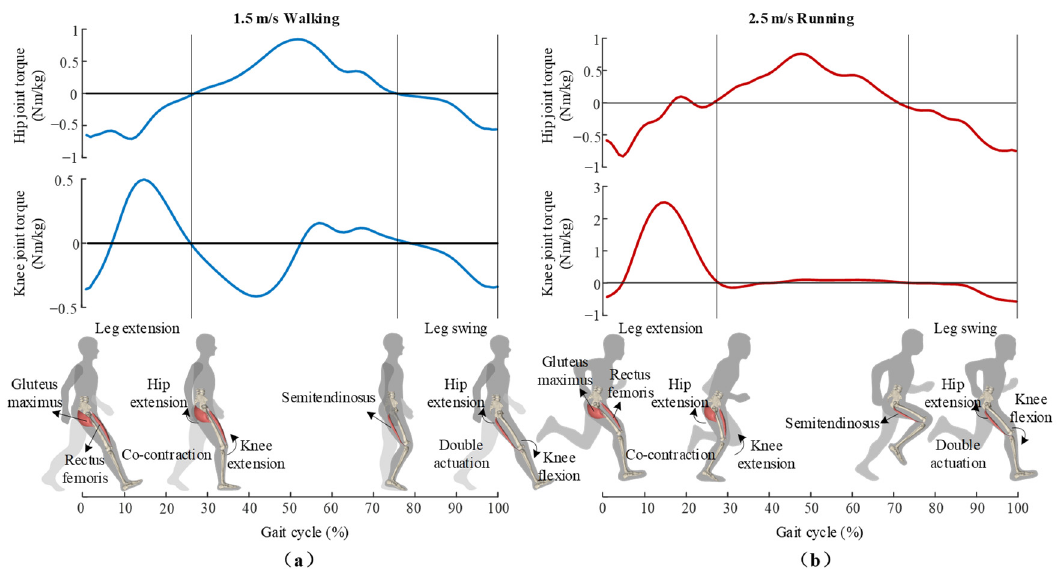
Figure 1. Joint torque and actions of biarticular muscles during ( a ) walking and ( b ) running. The semitendinosus (biarticular muscle) store part of kinetic energy during leg swing to provide hip with extension torque. The gluteus maximus (biarticular muscle) and rectus femoris (biarticular muscle) co-contract during leg extension.